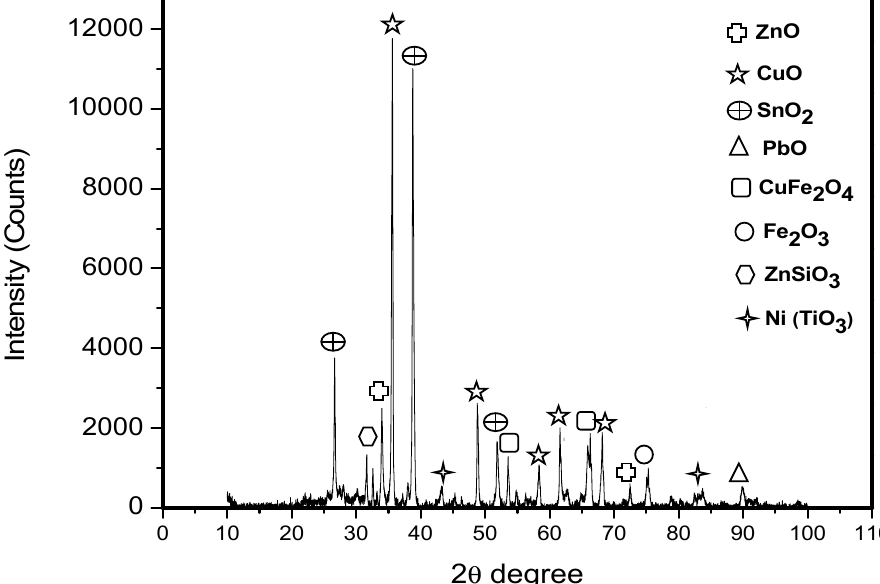
Figure 2. The observed X-ray diffraction (XRD) pattern of powdered PCBs sample.